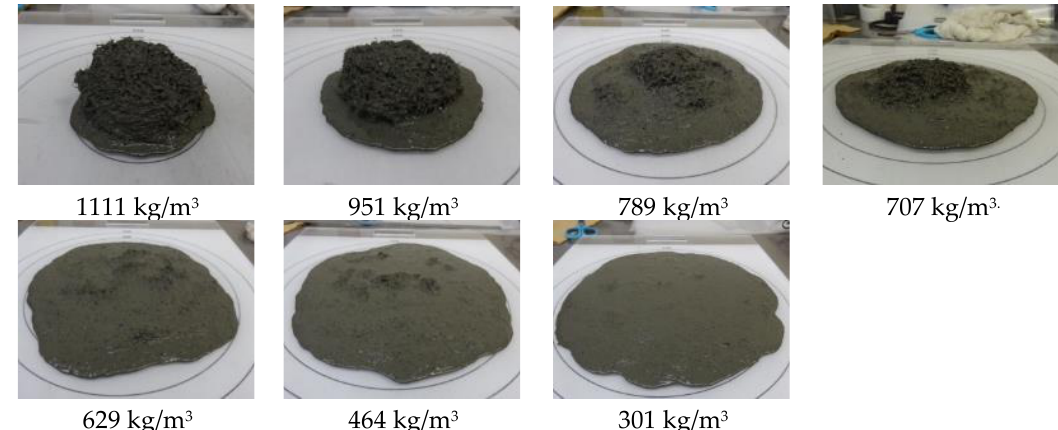
Figure 21. Mortar flow varied by volume of fine aggregate. Figure 22. Size distributions of materials without steel fibres.